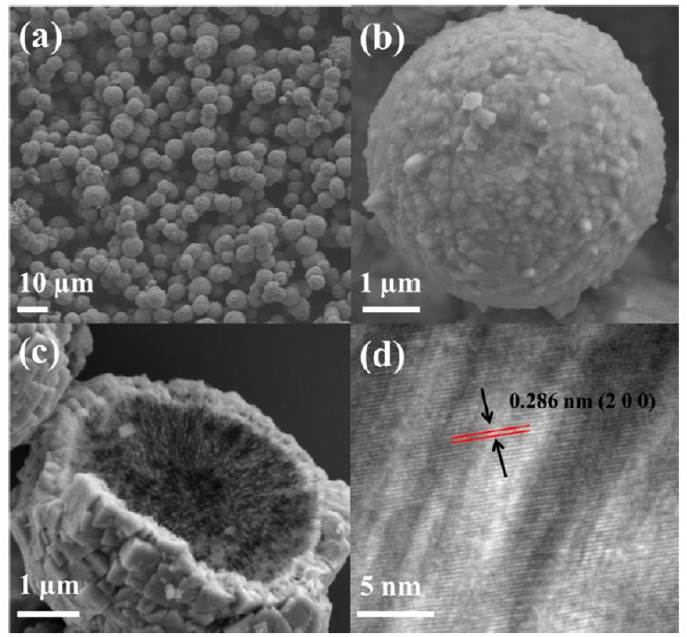
Figure 19. ( a – c ) Field emission scanning electron microscopy (FESEM) images of NiS 2 hollow microspheres at different magnifications. ( d ) High-resolution transmission electron microscope (TEM) image of NiS 2 . Reproduced with permission from [13].